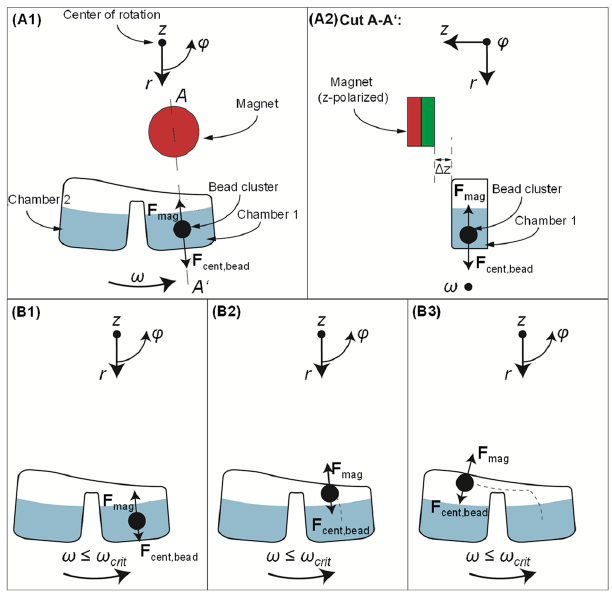
Figure 1. Schematic of the principle of gas-phase magnetophoresis under rotation. ( A1 ): Two microfluidic chambers are located radially outwards from a magnet. During rotation, the magnetic beads undergo the centrifugal force, F cent,bead and the magnetic force, F mag (notably, only the radial component of the F mag vector is indicated here, as it is the one that influences the magnetophoresis between the chambers). The A-A’ cut ( A2 ) shows the distance, ∆ z, between the magnet and the top of the cartridge, in the z -direction. ( B1 , B2 ): When the rotation takes place at an angular velocity below a critical value, ω crit , the magnetic force is higher than the centrifugal force, thereby the pellet is pulled radially inwards. ( B3 ): Azimuthal transfer of the magnetic beads to a downstream chamber. This movement is supported by the bead cluster inertia depending on the direction of